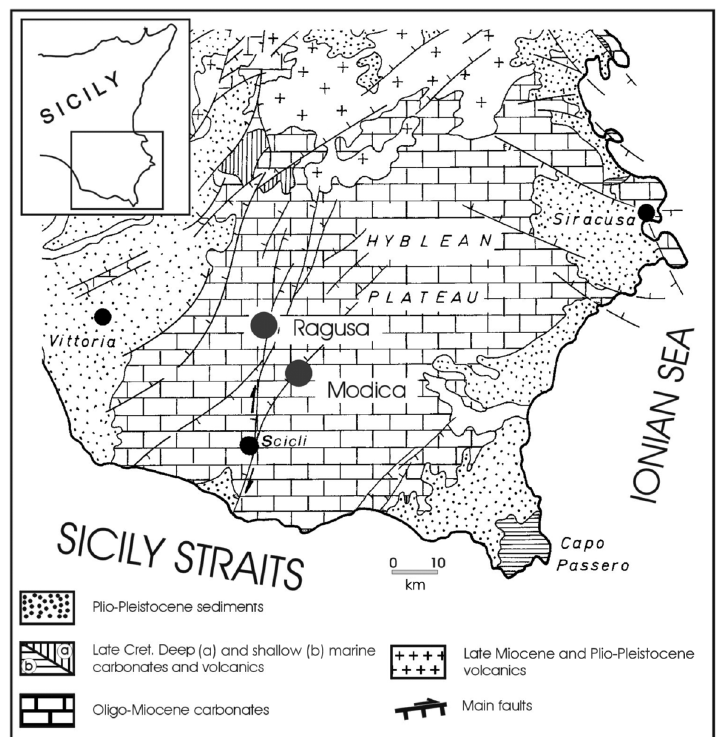
Fig. 1. Site location: the Hyblean